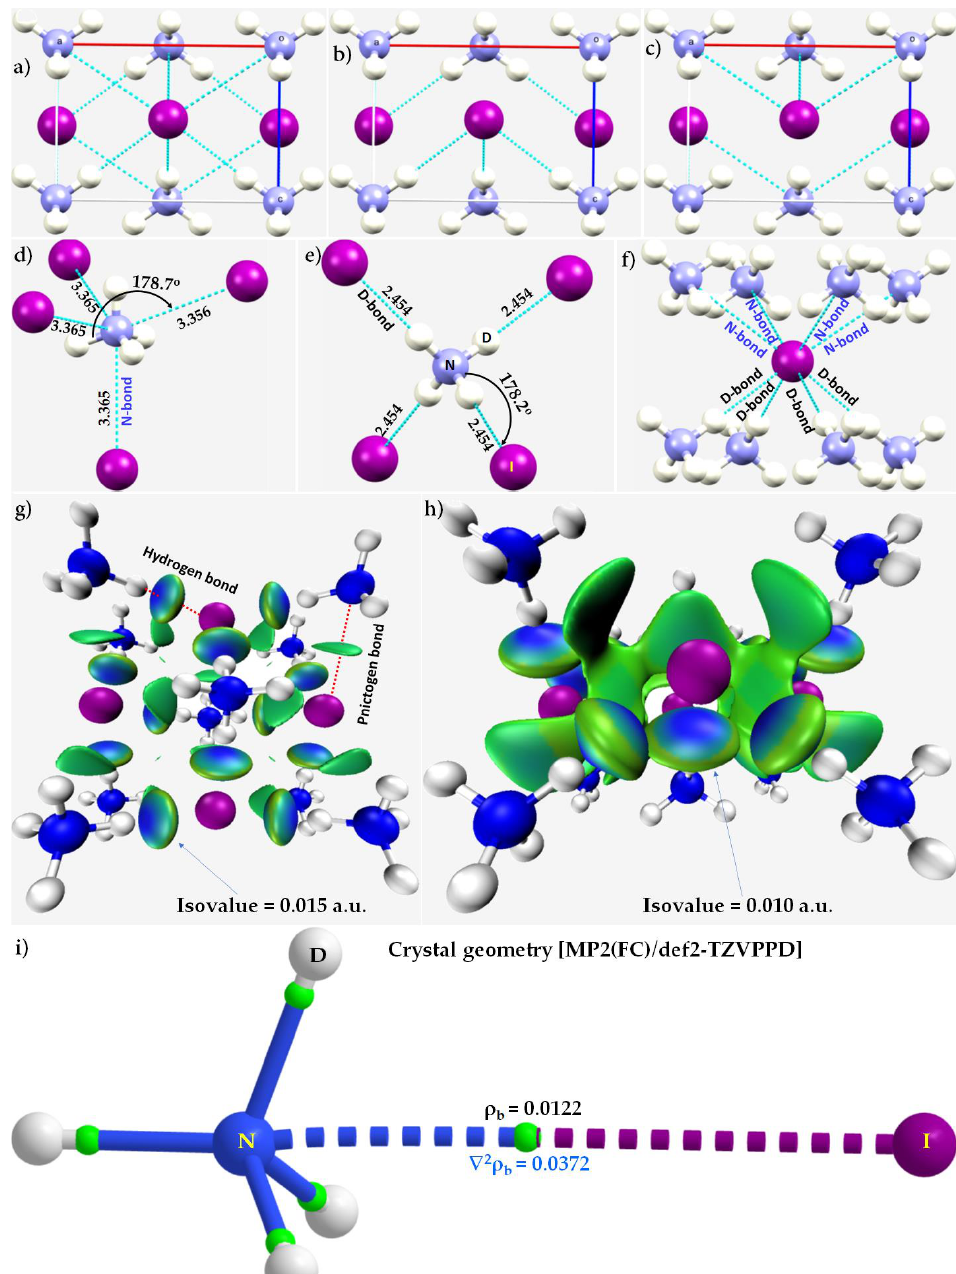
Figure 11. Three views of the crystal of ND 4 I (ICSD ref. 89094 [103]), showing ( a ) combined D ··· I deuterium bonds and N ··· I pnictogen bonds, ( b ) D ··· I deuterium bonds, and ( c ) N ··· I pnictogen bonds. Illustration of the nature of local nature of multi-furcated charge-assisted intermolecular bonding topologies: ( d ) N in ND 4+ as four pnictogen bond donors; ( e ) ND 4+ as four D bond donors; ( f ) I − as four D-bond and four N-bond acceptors; ( g , h ) IGM-based isosurface plots between the interacting units as in the unit-cell of the crystal, with isovalues of 0.015 and 0.010 au, respectively. Selected bond lengths and bond angles are in Å and degrees, respectively. The dotted lines represent inter-ionic interactions. Atom type is shown in ( e ). ( i ) MP2(FC)/def2-TZVPPD level QTAIM-based molecular graph for the ion-pair ND 4 I, obtained on its geometry as in the crystal; it shows the bond paths as sticks and dotted lines in atom color, bond critical points as tiny spheres between atomic basins in green, and values (in a.u. ) of charge density ρ b and the Laplacian of the charge density ∇ 2 ρ b at the N ··· I bond critical